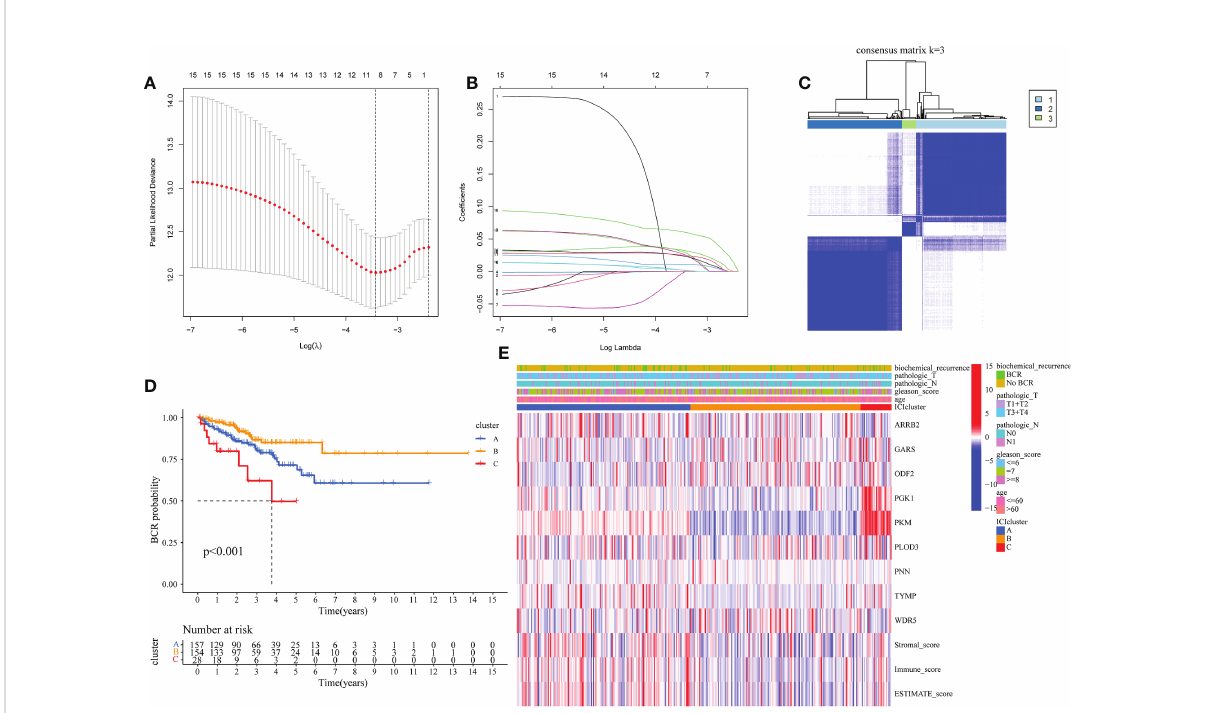
FIGURE 2 Classi fi cation of PRAD based on moonlighting genes in TCGA. (A, B) Lasso regression analysis of 16 candidate moonlighting genes, and 9 genes were excluded for the signature. (C) The classi fi cation of PRAD patients based on the consensus clustering matrix (k = 3). (D) KM curves of BFFS between 3 clusters. (E) Heatmap of the clinicopathologic features and 9 genes in